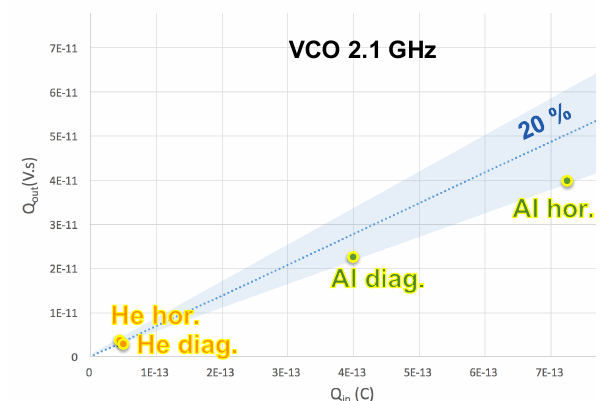
Fig. 21. Calibration curve for injected charge versus output charge, concerning diagonal configurations, for the aluminum ion or the alpha particle crossing in a fifteen contacts matrix. Only bottom currents are injected in the 2.1GHz